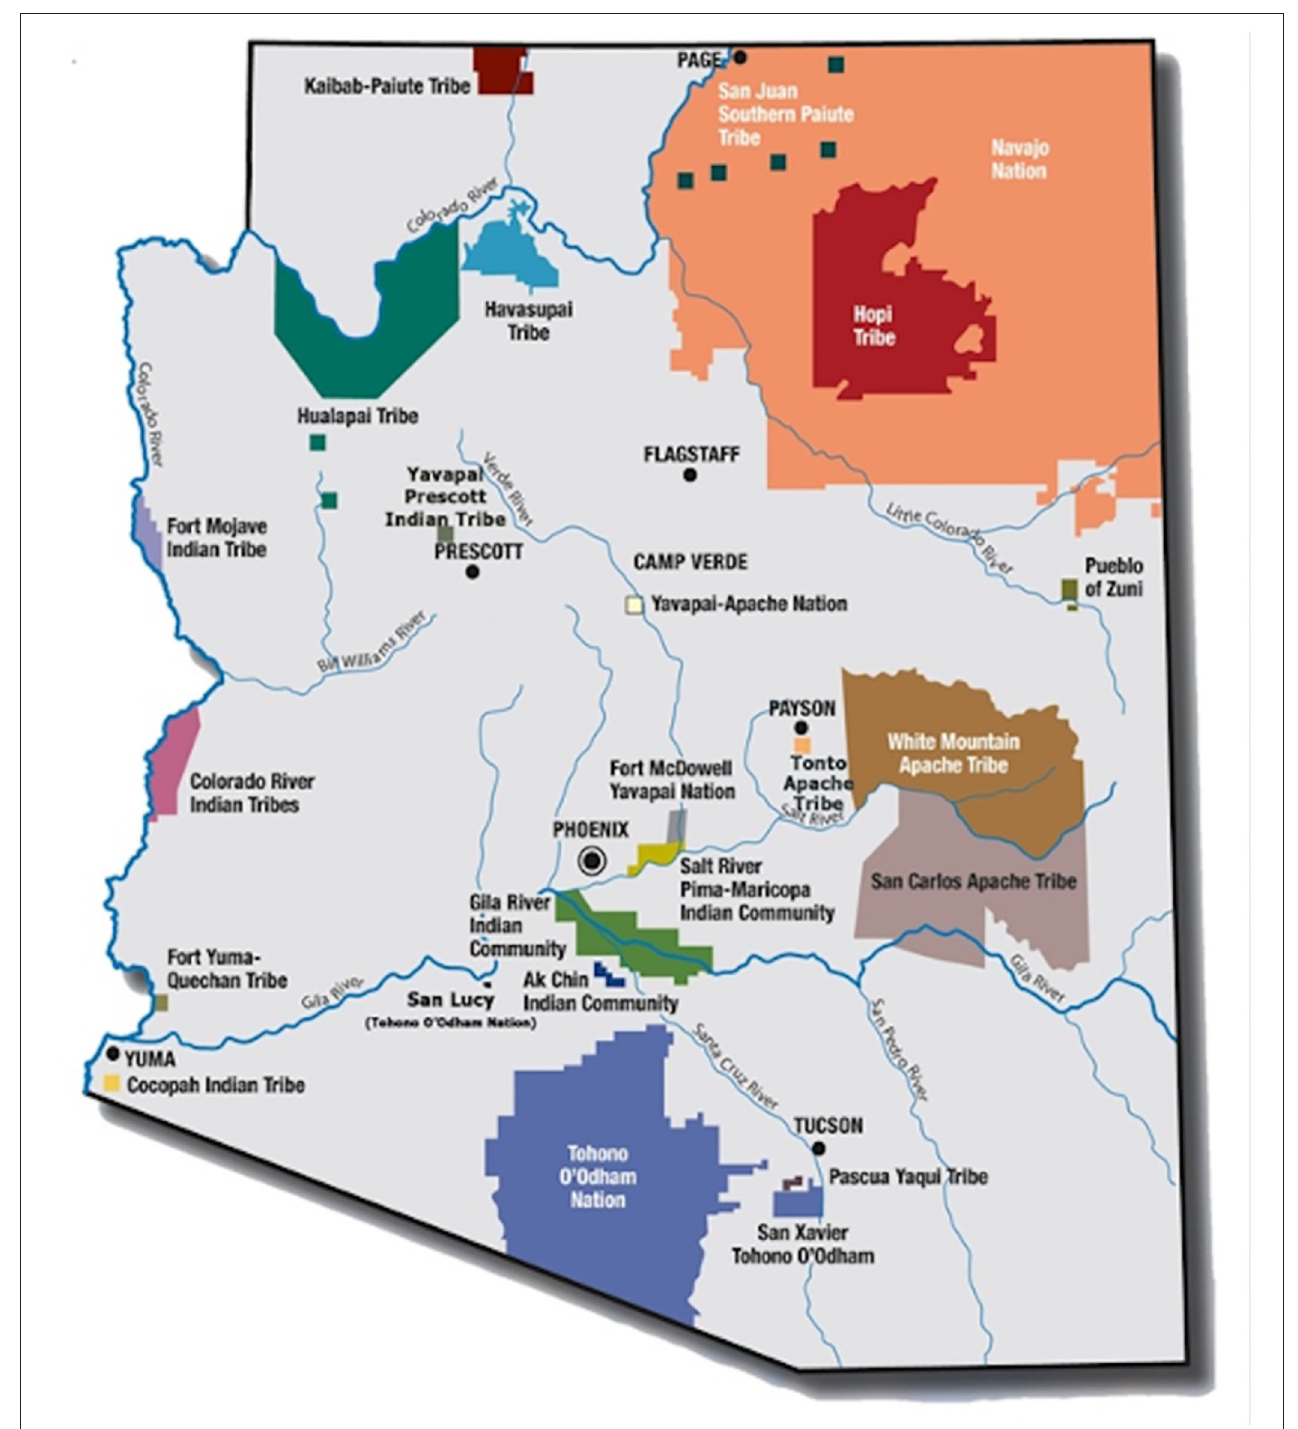
FIGURE 1 | Native nations of